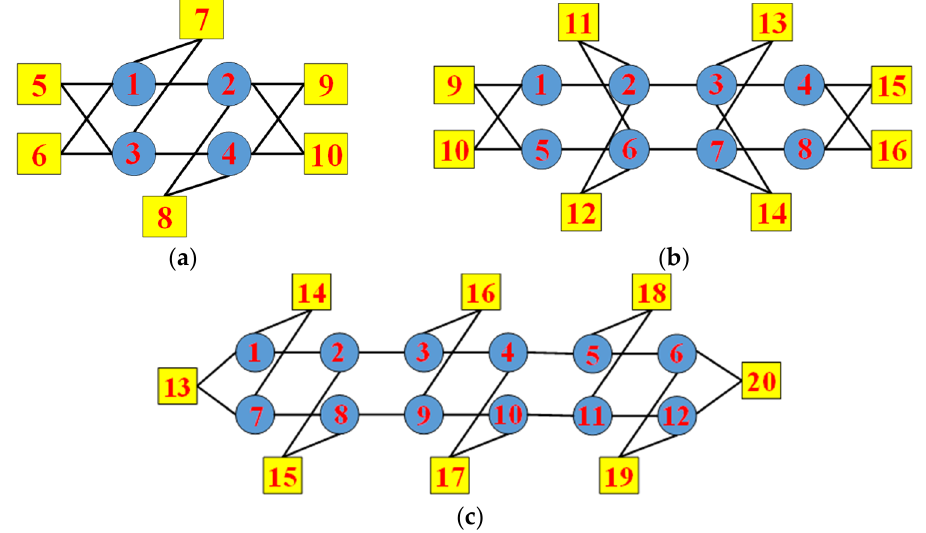
Figure 4. Topology diagram of AFDX with ( a ) 10 nodes; ( b ) 16 nodes; and ( c ) 20 nodes.